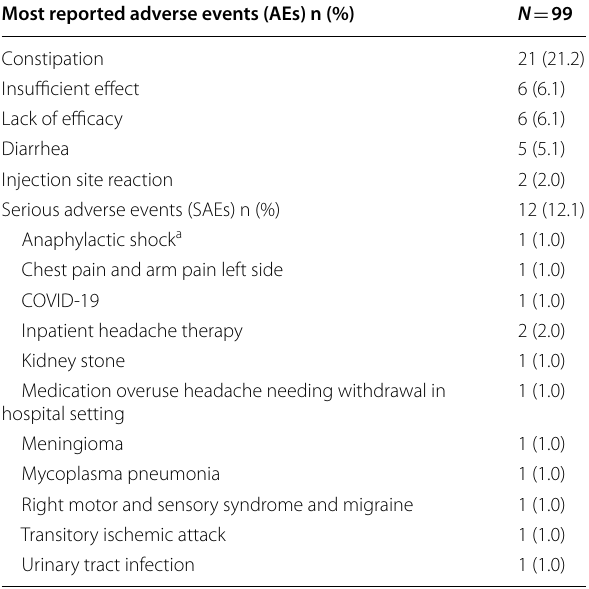
Table 4 Adverse and serious adverse events up to 6 months of